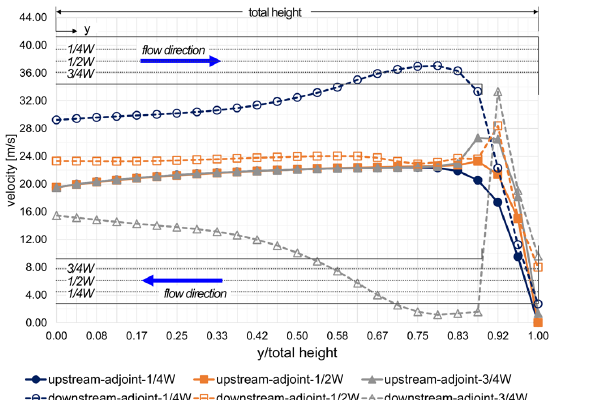
Figure 16. Velocity contour at the center of the x-coordinate using the adjoint solver (Re = 24,230).